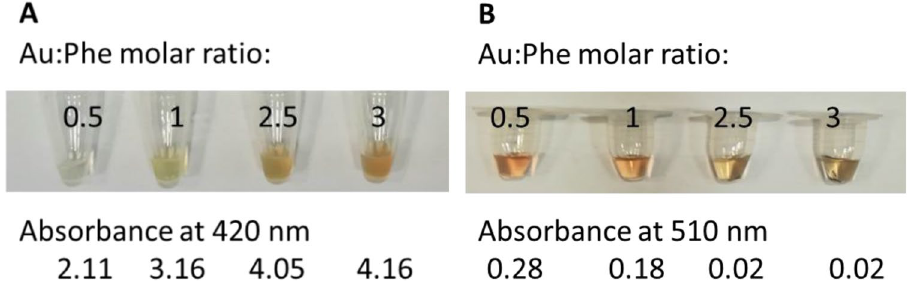
Figure 2. The first step of the reduction by amine of Phe. ( A ) Ammonium production is confirmed by Nessler’s reaction. ( B ) The removal of amine functional group from Phe is confirmed by benzoquinone reaction. There is no detectable amine at molar ratios of 2.5 and 3 while it still exists in lower molar ratios of 0.5 and 1.